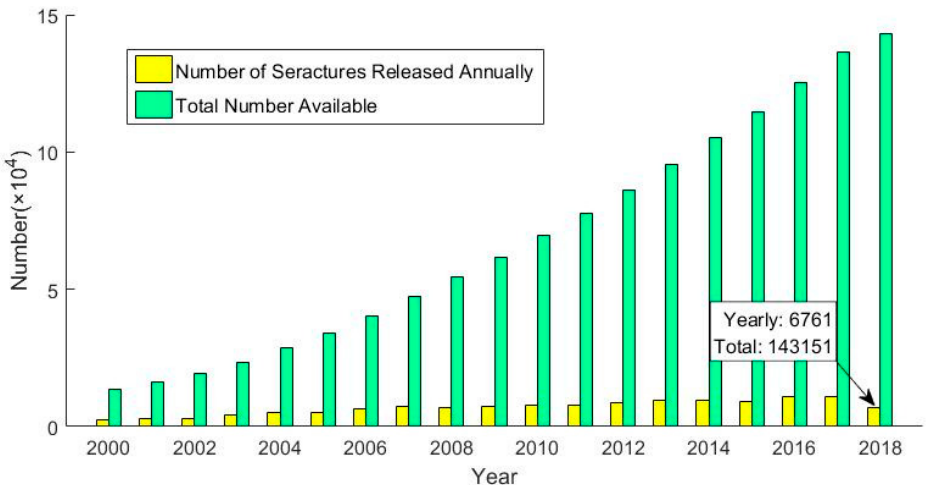
Figure 1. Annual release of compound structure and total structure quantity statistics.